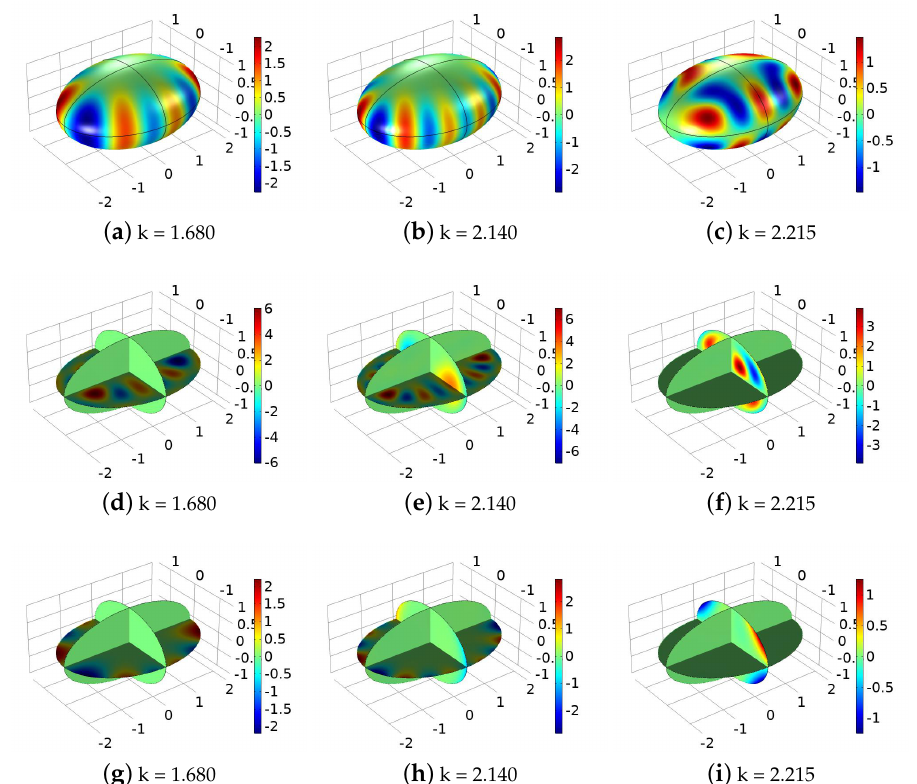
Figure 4. The magnitude of transmission eigenfunctions for an ellipsoid with different k ’s.